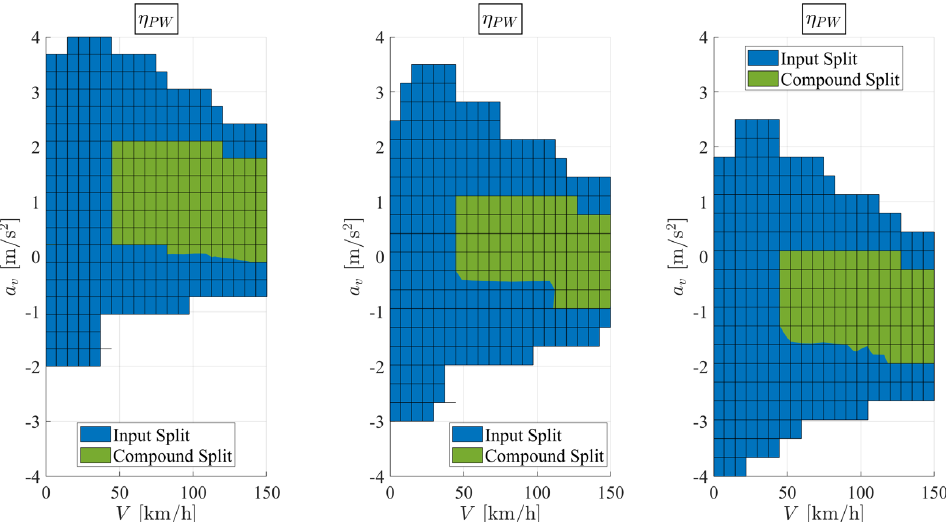
Figure 16. Resulting powertrain mode map for the two-mode hybrid system for a α = − 10% ( left ),